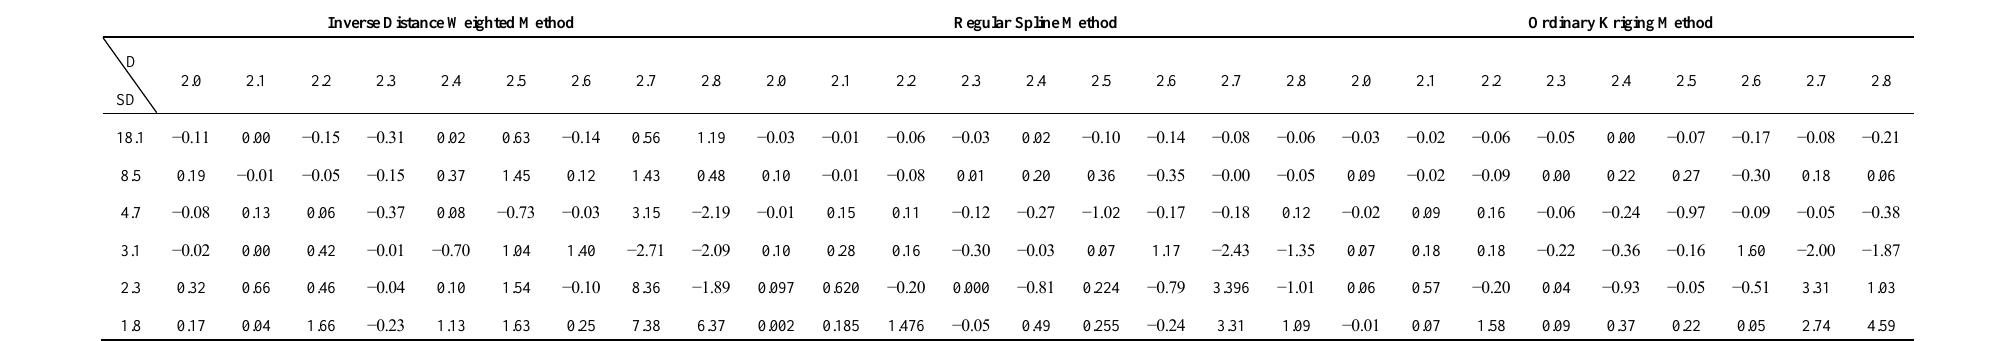
Table 4. The BIAS s under regular-grid sampling mode (Unit: